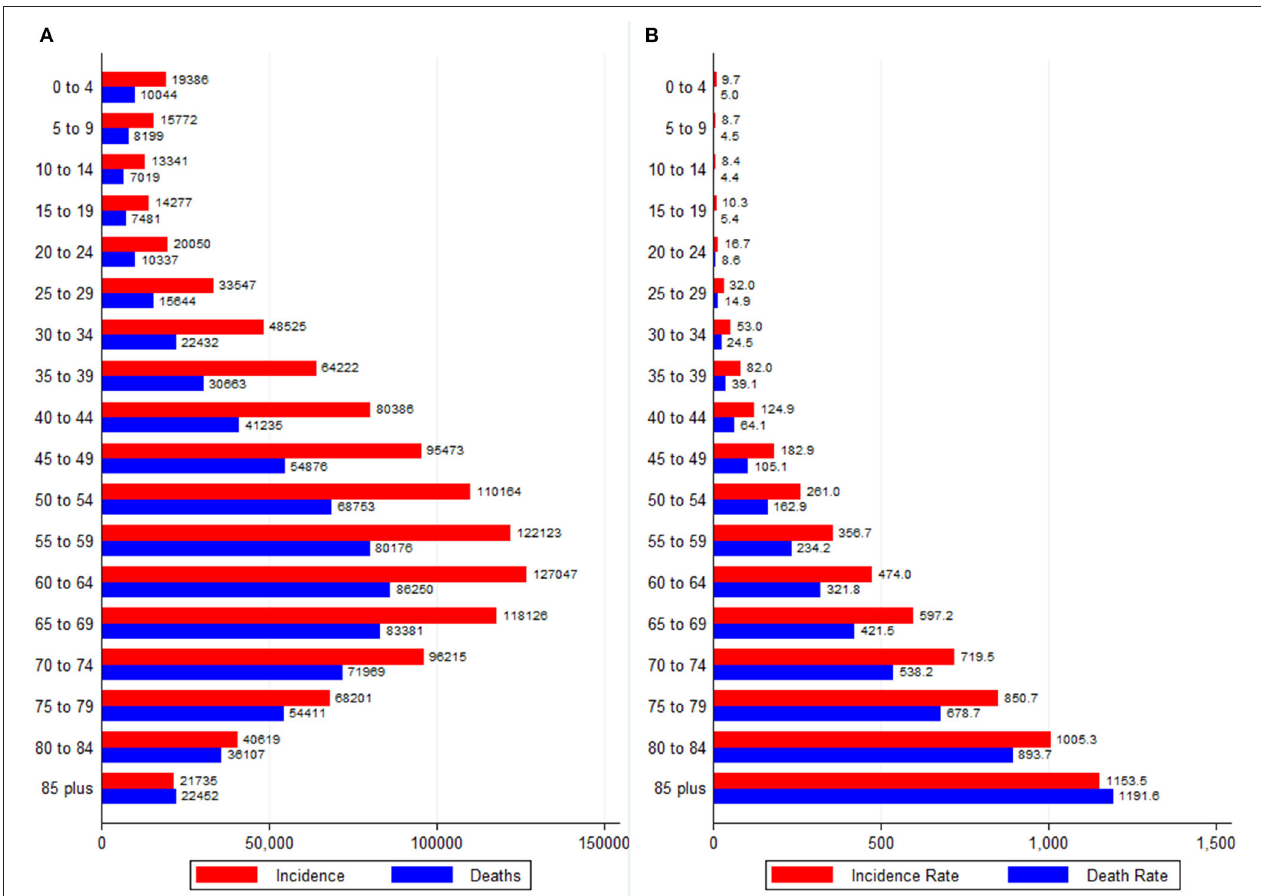
FIGURE 4 | Age-specific burden of all neoplasms in Africa, 2020. (A) Absolute numbers and (B) Rates per 100,000 people. Data source: GLOBOCAN 2020 (International Agency for Research on Cancer).